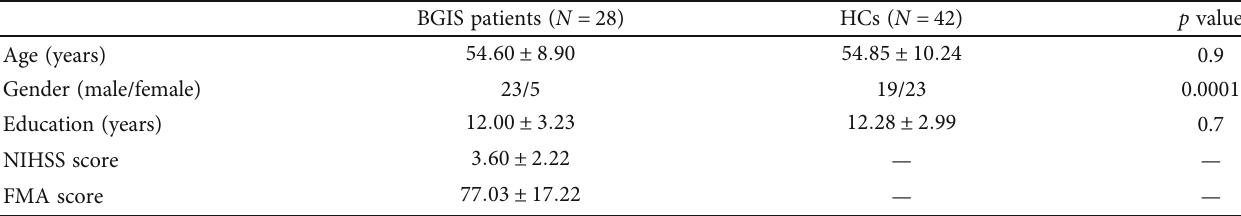
Table 1: Demographic and clinical information of